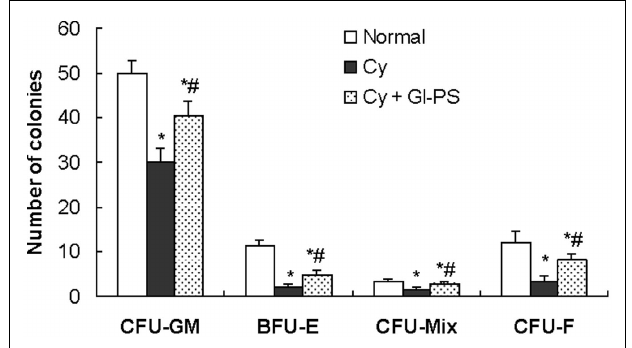
FIGURE 2 | Effects of Gl -SP on the clonogenic activity of various hematopoietic progenitor cells and stromal cells in the bone marrow in vivo . On day 11 after Cy treatment, BMC (5 × 10 4 ) were plated on CFU-GM, BFU-E, and CFU-Mix culture system. * P < 0.05 versus the normal control; # P < 0.05 versus the vehicle-administered Cy group.